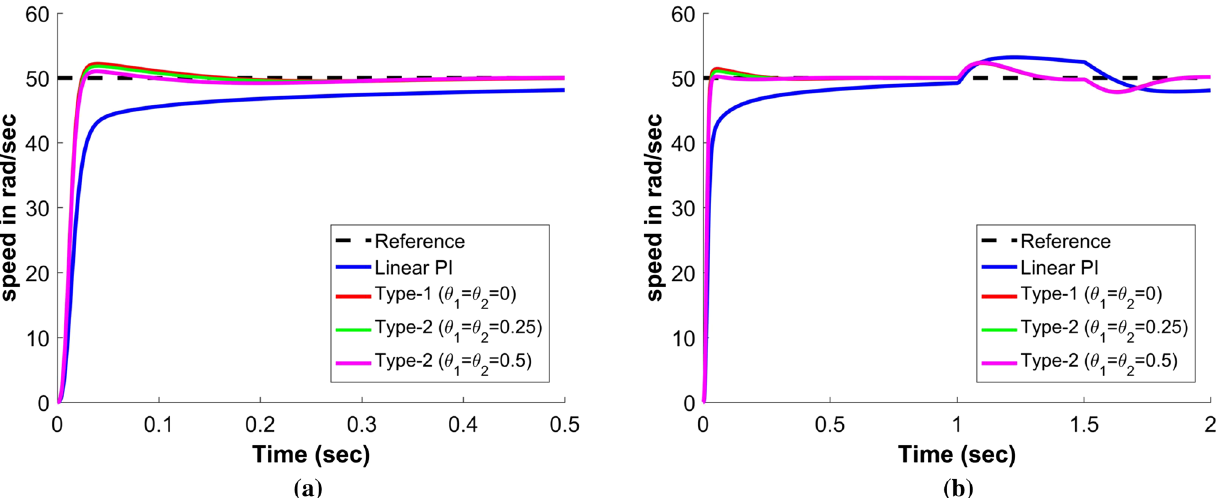
Fig. 15 Set-point responses of DCM with ( a ) varying FoUs ( 0 ≤ 𝜃 1 ∕ 𝜃 2 ≤ 0.5 ) and ( b ) in the presence of input disturbance and parameter varia- tions